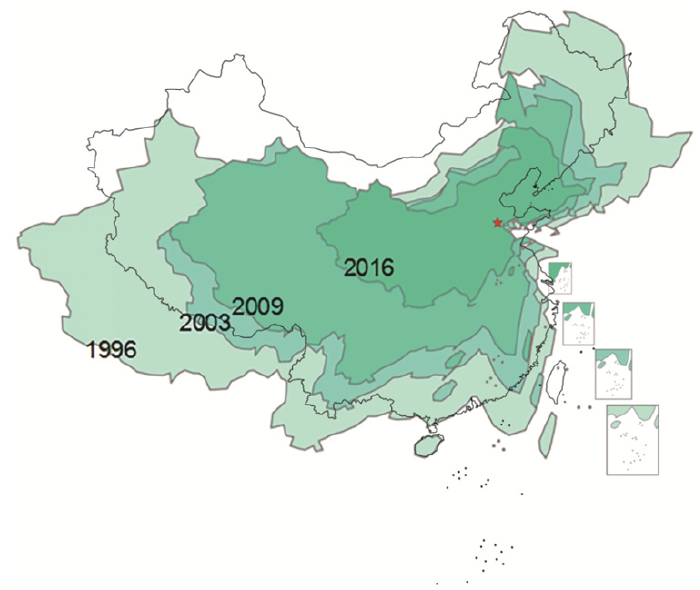
Figure 10. Time–space overlay analysis in the same time scale from 1996 to 2016 (Maps in this figure are demonstrations of experiment results, not the real territory of the study area).